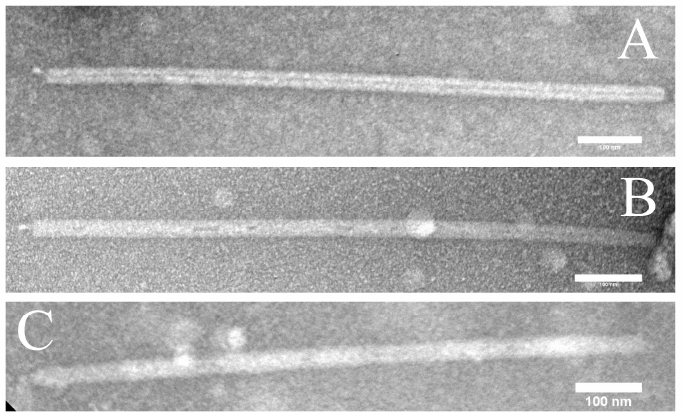
Figure 2. Virion Morphology. Transmission EM of lysates stained with uranyl acetate (see Section 2). Panel ( A ): isolate V3; panel ( B ): isolate V60; panel ( C ): isolate V65.